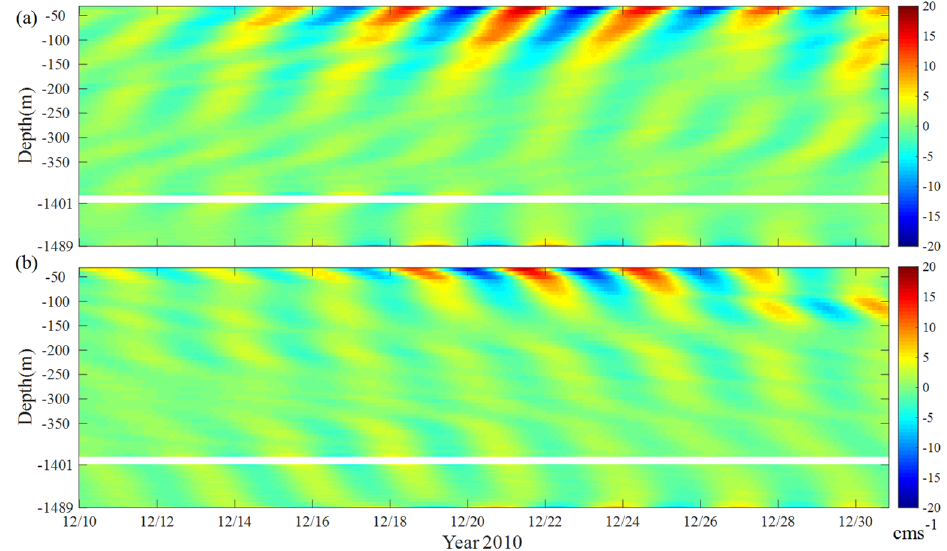
Figure 9. Depth-time maps of the ( a ) upward phase (downward energy) propagating eastward near-inertial velocity components and ( b ) downward phase (upward energy) propagating eastward near-inertial velocity components in December 2010.